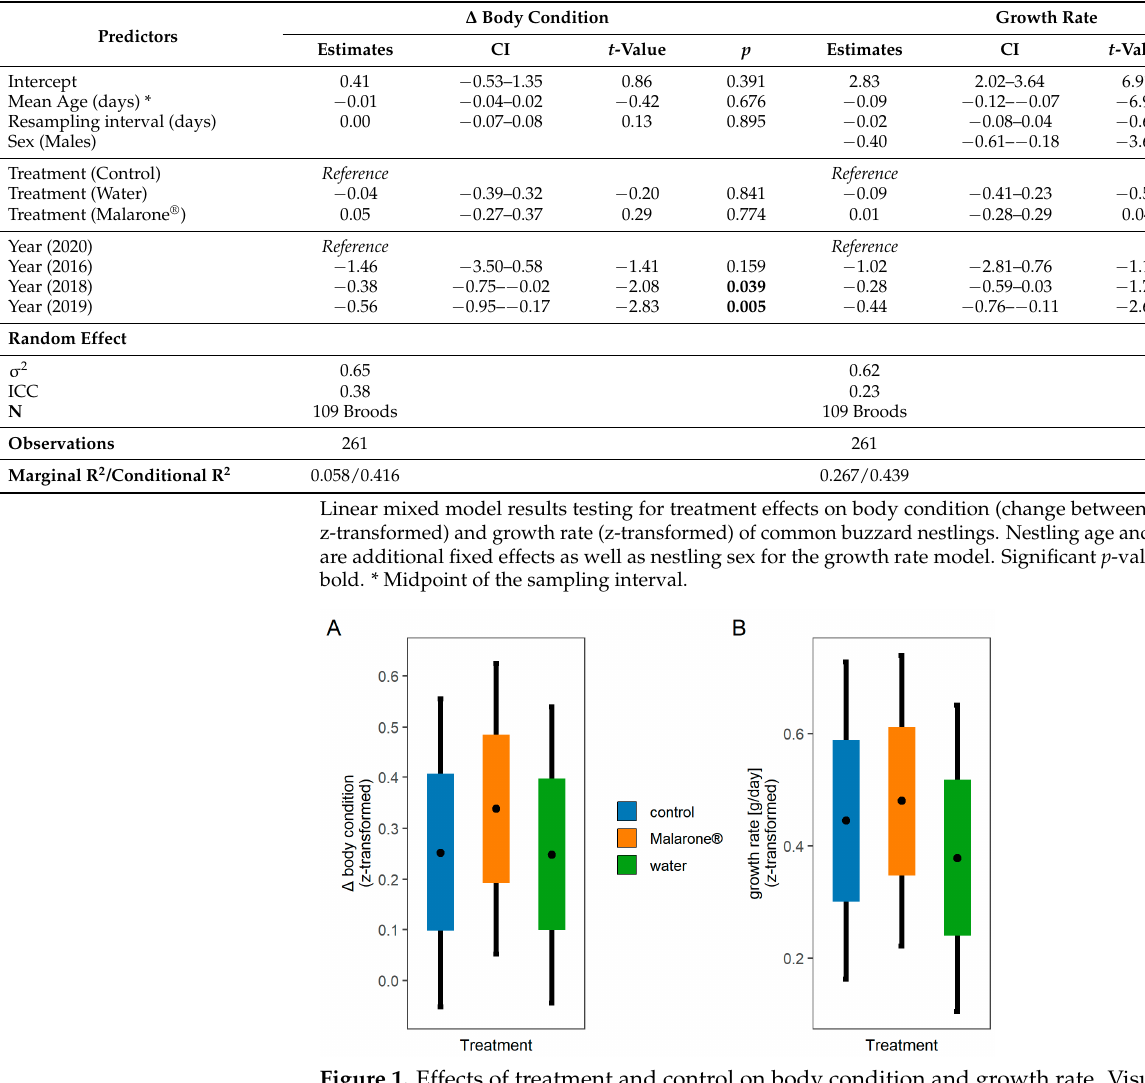
Figure 2. Regression analyses for weight and wing length. Visualisation of regression analyses for weight and wing length of control, Malarone ® -, and water-treated nestlings (solid line) in compari- son to the reference data of common buzzards [20] (dotted black line) for female ( ♀, n = 136) and male ( ♂, n = 163) individuals. Circles represent values at first sampling, triangles at second sam- pling. R 2 represents the proportion of variance explained by both fixed and random effects in each model.